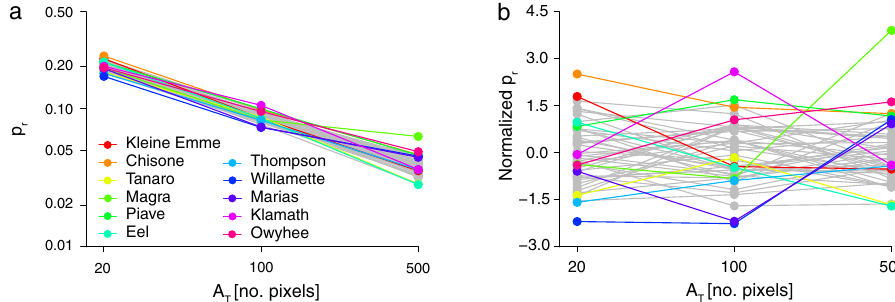
Fig. 3 Values of branching ratio as a function of A T for the 50 real river networks analyzed in this study. a Natural values of p r in logarithmic scale. b z - normalized branching ratios (i.e., for each A T value, values of p r are normalized so that they have null mean and unit standard deviation), which better shows how rivers rank differently in terms of p r for different observation scales (i.e., A T ). Lines connect dots relative to the same river. For visual purposes, rivers that rank fi rst, second, second-to-last or last in at least one of the A T groups are displayed in colors; the other rivers are displayed in determined from geomorphological arguments: for instance, large fi shes inhabit wide and deep river reaches, and do not access